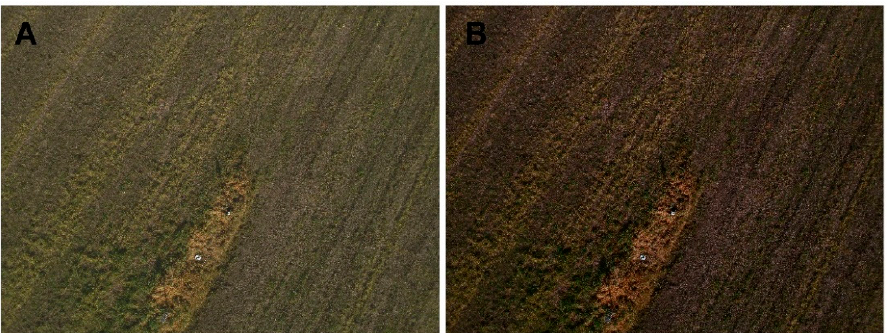
Figure 3. Examples of calibrated ( A ) and non-calibrated ( B ) images including a GCP; Day 2, Zone 5.